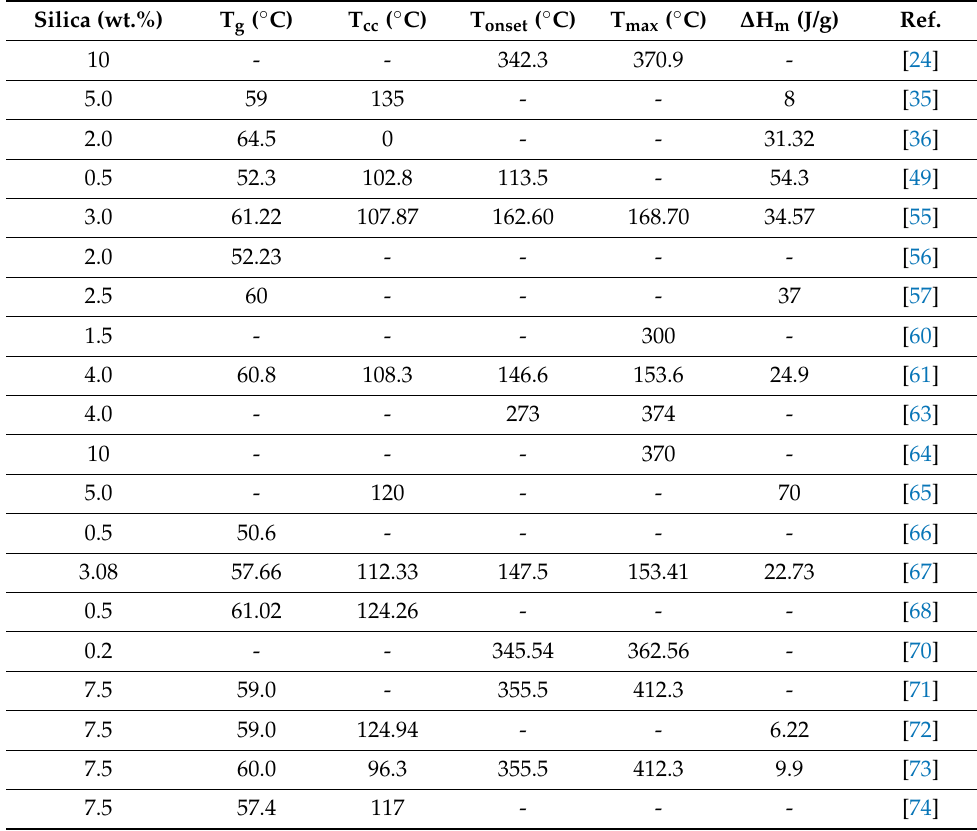
Table 1. The influence of silica incorporation on the thermal properties of PLA composites. Silica